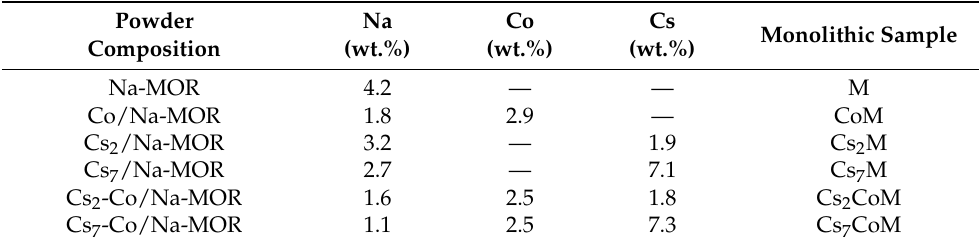
Table 1. Elemental composition of powders and monolithic